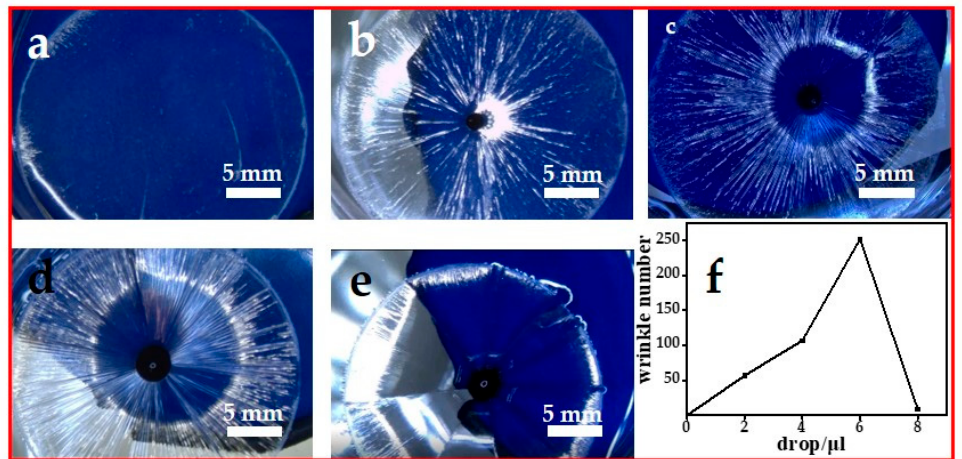
Figure 4. Optical microscopy images of surface morphologies on the floating PS film ( a ) without a magnetic droplet and with a ( b ) 2 μ L, ( c ) 4 μ L, ( d ) 6 μ L, ( e ) 8 μ L magnetic droplet on it, when the PS film is 100 nm thick, and the magnet is 7.5 mm away from the magnetic droplets. ( f ) The relationship of wrinkle number versus magnetic droplet size, thereinto the experimental point that the 8 μ L magnetic droplet corresponds to is the fold number, not the wrinkle number.